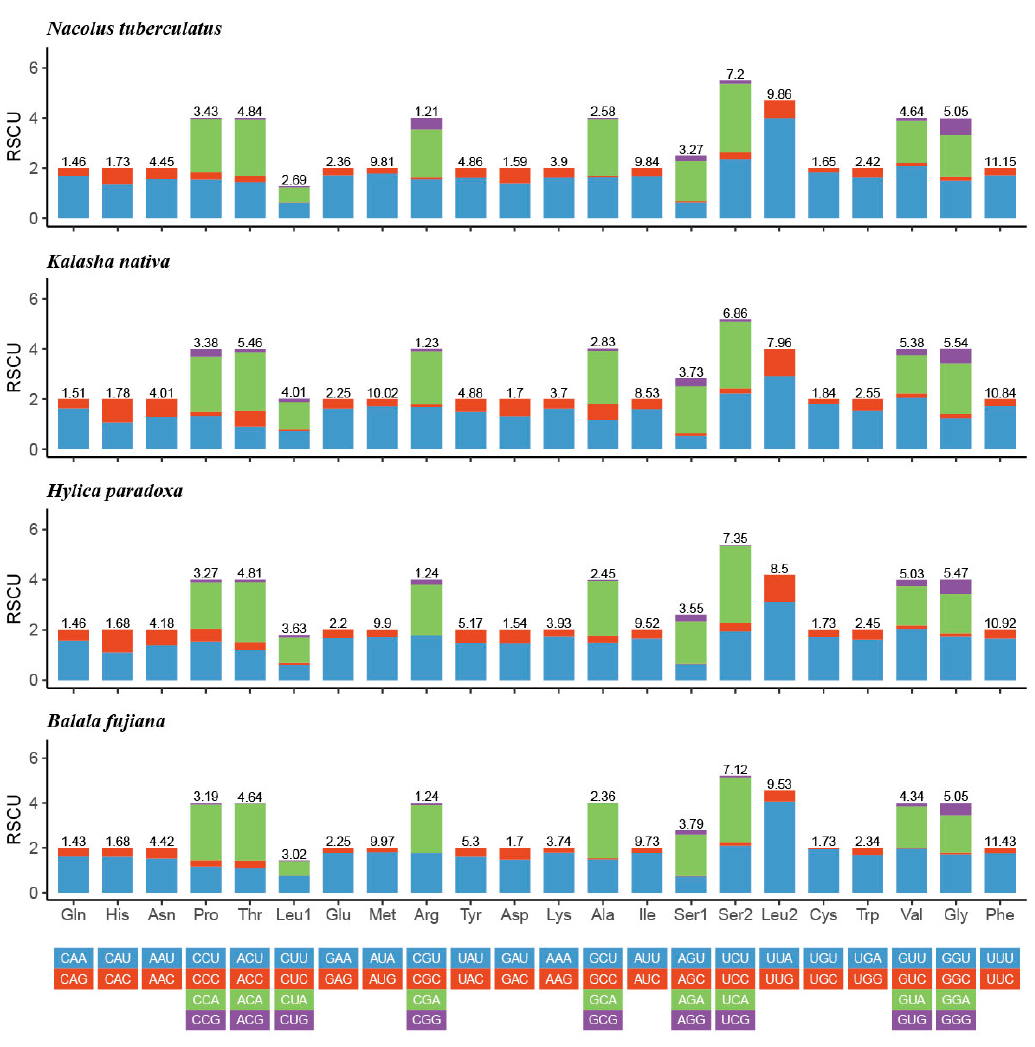
Figure 3. Relative synonymous codon usage (RSCU) of the mtgenomes of four Hylicinae species.